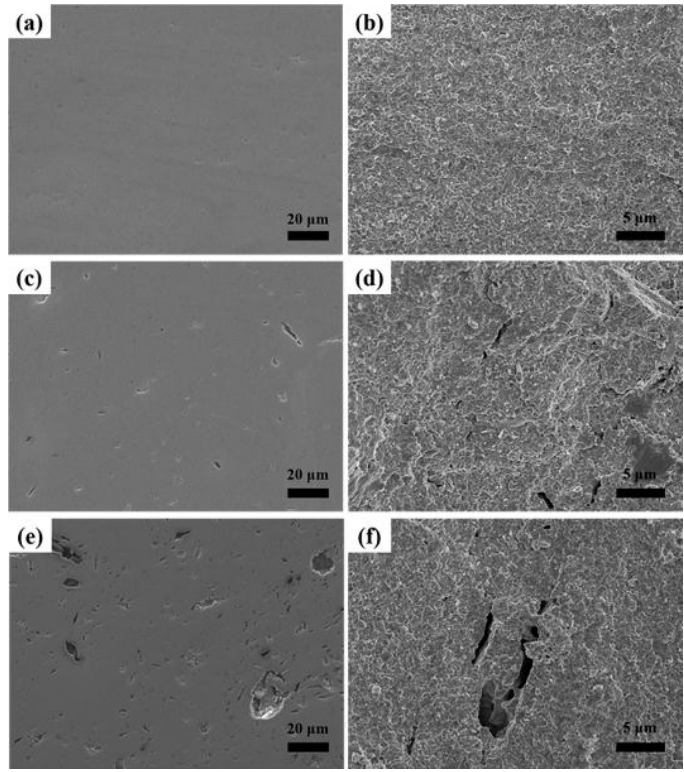
Figure 2. SEM images of polished surfaces and fracture surfaces of zirconia ceramics with different